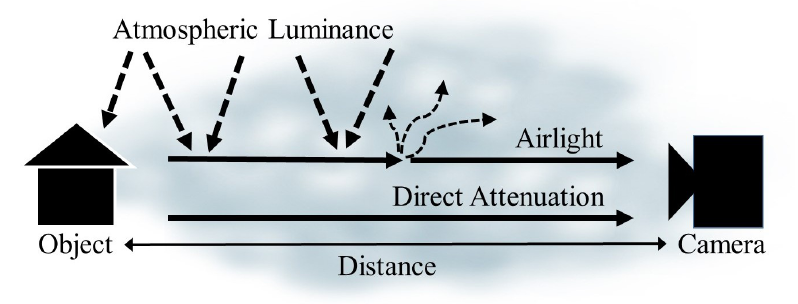
Figure 1. Illustration of the foggy image formation